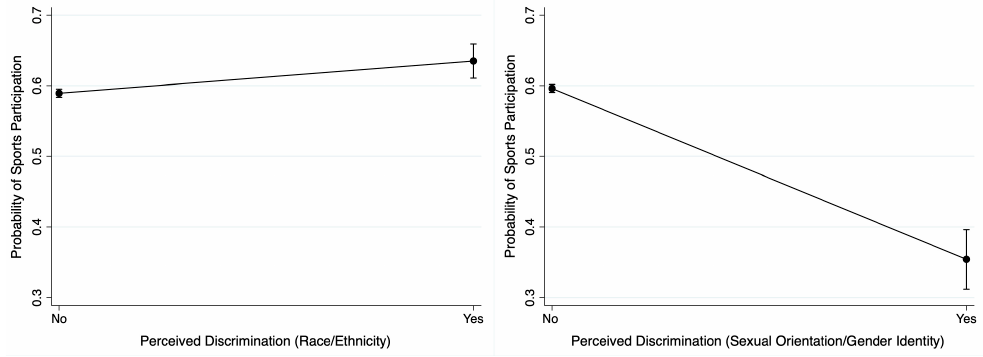
Figure 1. Adjusted predicted probabilities for out-of-school sports participation as a function of perceived parental discrimination because of the child’s race/ethnicity ( left ) and because of the child’s sexual orientation/gender identity ( right ). Note : Predicted probabilities adjusted for covariates.